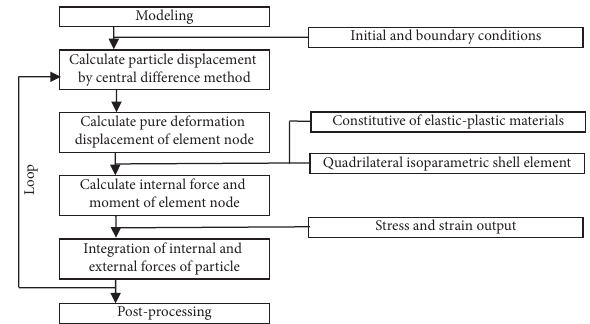
Figure 1: Analysis fow chart for shell structures.